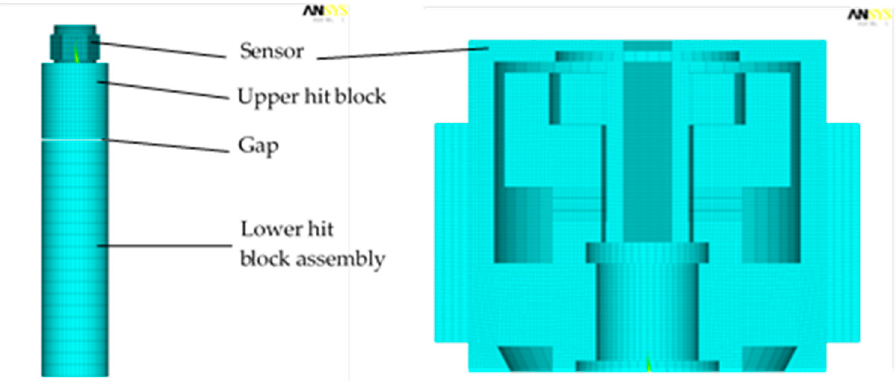
Figure 8. The dynamic simulation for test bench and sensing system.